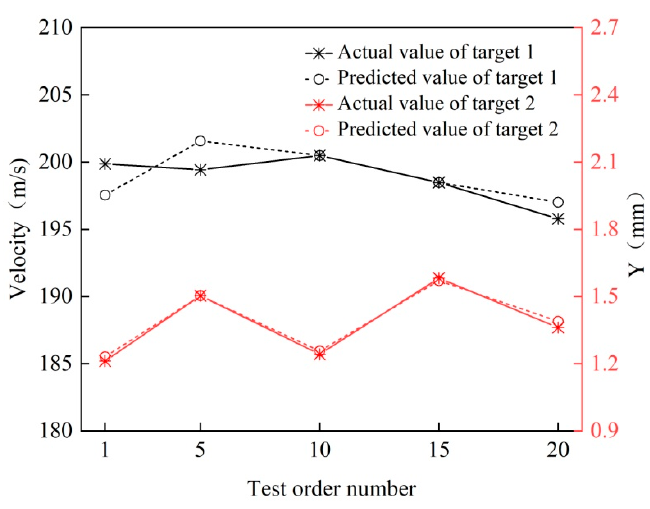
Figure 9. Fitness curve of sample.